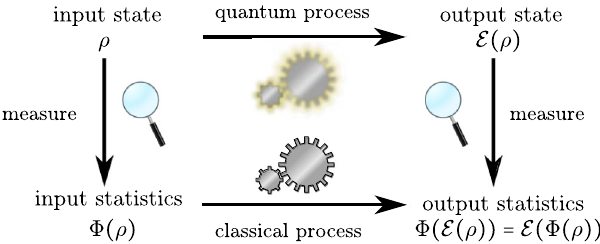
FIG. 1. Incoherent operations cannot create coherence; strictly incoherent operations, in addition, cannot use coherence. We depict here an SI operation E , showing that all the initial coherence in the input ρ can be removed with a measurement Φ (in the incoherent basis) without affecting the final measure- ment